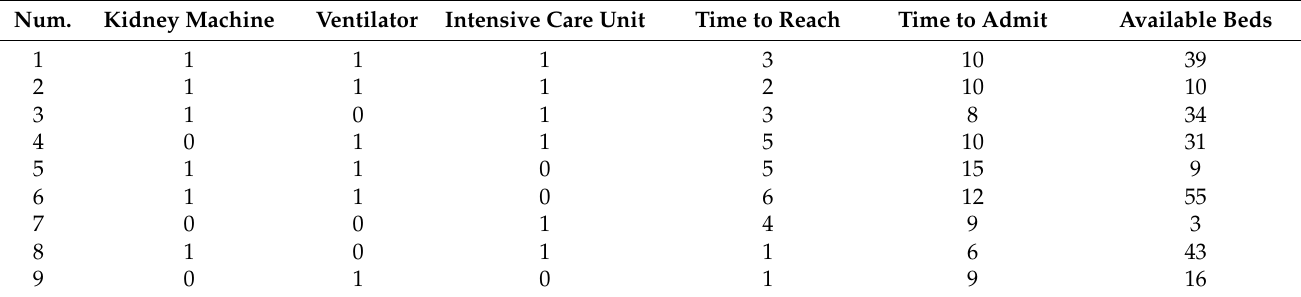
Table 3. The medical preparations, reach times, and admission times of nine